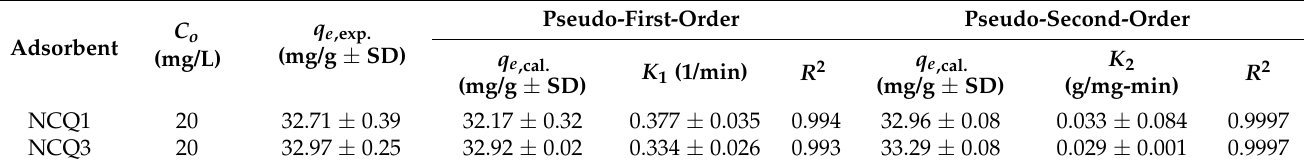
Figure 7. ( a ) Nonlinear isotherm adsorption models for CV dye adsorption onto NCQ1 ( b ) and NCQ3 adsorbents. ( c ) Nonlinear kinetic adsorption models for CV dye adsorption onto NCQ1 ( d ) and NCQ3 adsorbents. Table 4. Nonlinear isotherms models for CV dye adsorption on both NCQ1 and NCQ3 adsorbents. Table 5. Nonlinear kinetics model for CV dye adsorption on both NCQ1 and NCQ3